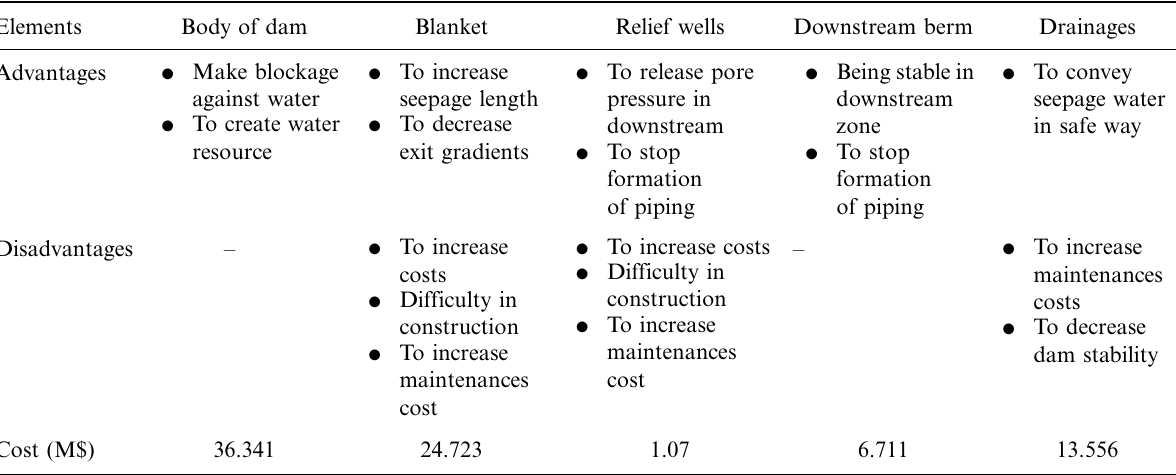
Table 3. The functions of elements, advantages, and disadvantages